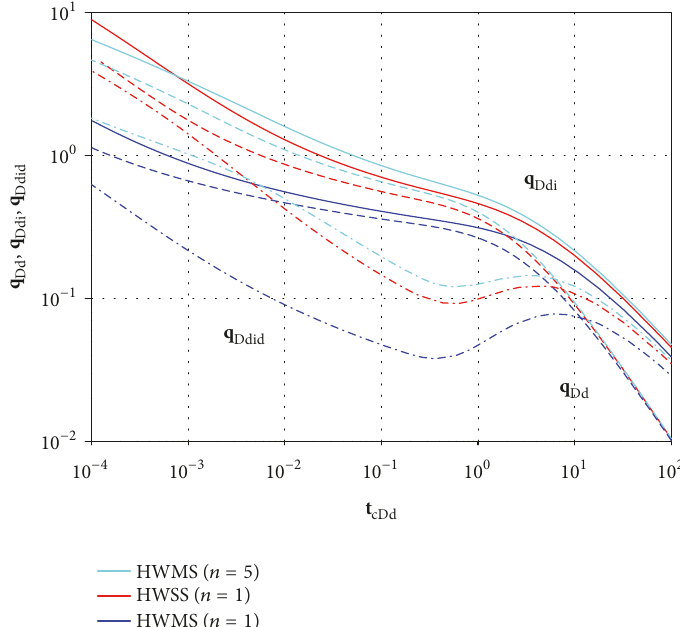
Figure 2: Blasingame compound type curves of HWMS and HWSS.